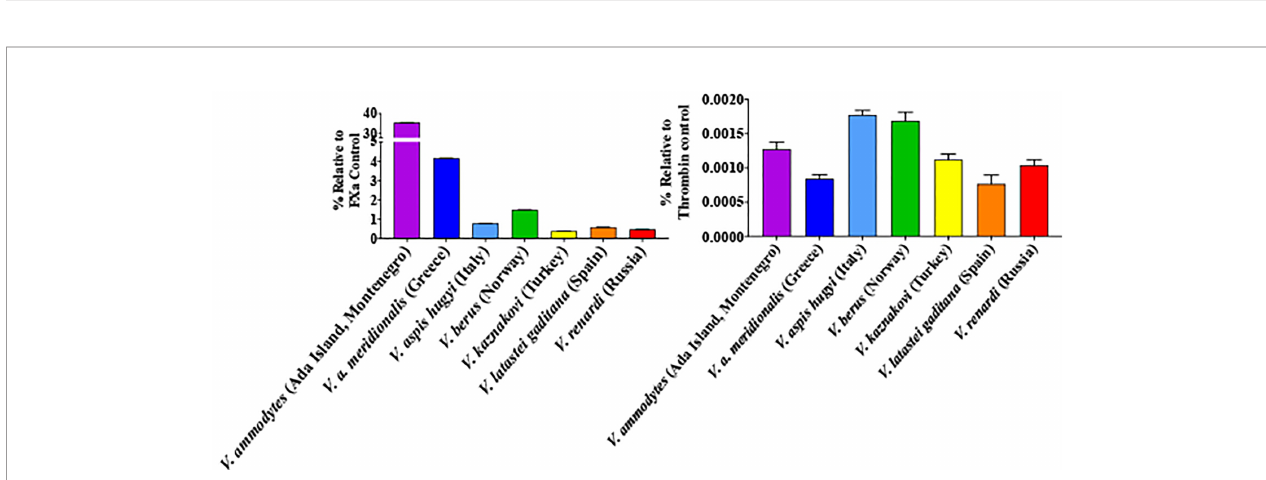
FIGURE 8 | Ability of venoms to activate Factor X (left) compared to prothrombin (right). Results are presented relative to the control of the same amount of the corresponding activated enzyme form (note difference in y-axis scales between the two graph sets). Data points are N = 3 mean ±